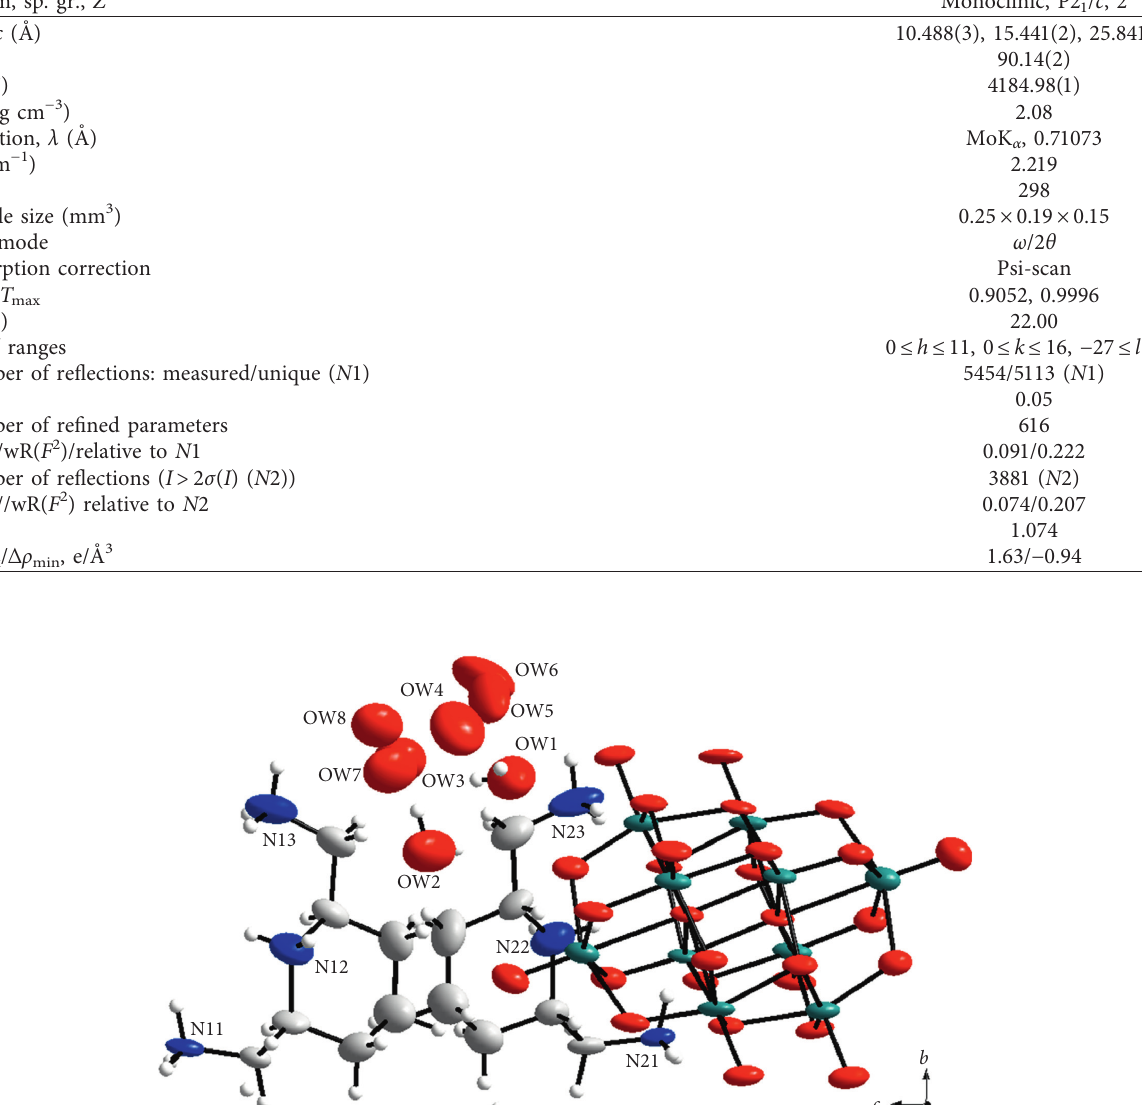
Table 1: Crystallographic characteristics, X-ray data collection, and structure-refinement parameters for (C System, sp. gr., Z